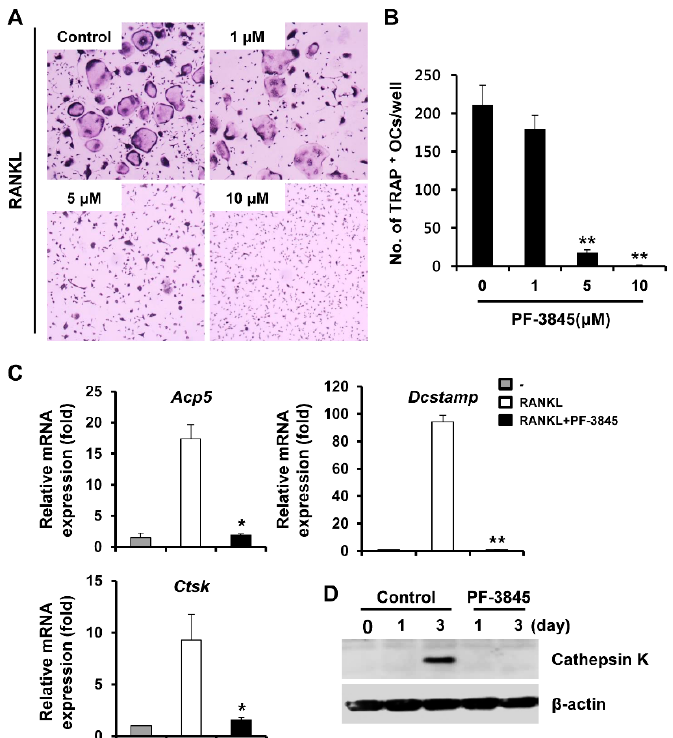
Figure 1. The effect of PF-3845 on receptor activator of nuclear factor kappa B ligand (RANKL)- induced osteoclast (OC) differentiation. ( A ) Bone marrow macrophages (BMMs) were incubated with macrophage-colony stimulating factor (M-CSF) (10 ng/mL) and RANKL (20 ng/mL) in the presence of indicated concentrations of PF-3845. After four days, tartrate-resistant acid phosphatase (TRAP) staining was performed. ( B ) The number of TRAP-positive cells containing three or more nuclei was calculated. ( C ) BMMs were cultured with M-CSF (10 ng/mL) and RANKL (20 ng/mL) in the presence of 10 µ M PF-3845 for four days. The mRNA expressions of osteoclast-specific genes were assessed by real-time PCR analysis, tartrate-resistant acid phosphatase ( Acp5 ), dendritic cell-specific transmembrane protein ( Dcstamp ), and cathepsin K ( Ctsk ). ( D ) BMMs were cultured in an osteoclastogenic medium with the vehicle or 10 µ M PF-3845 for an indicated number of days. Cathepsin K protein expression was evaluated by immunoblotting. * p < 0.05, ** p < 0.01 (two-tailed Student’s t -test).